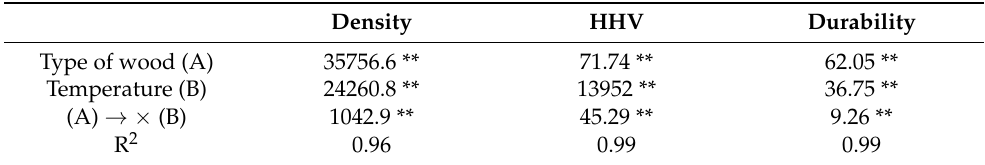
Table 3. Analysis of variance (F-value) of the effects of wood species and treatment temperature on the mechanical and physical properties of wood pellets.